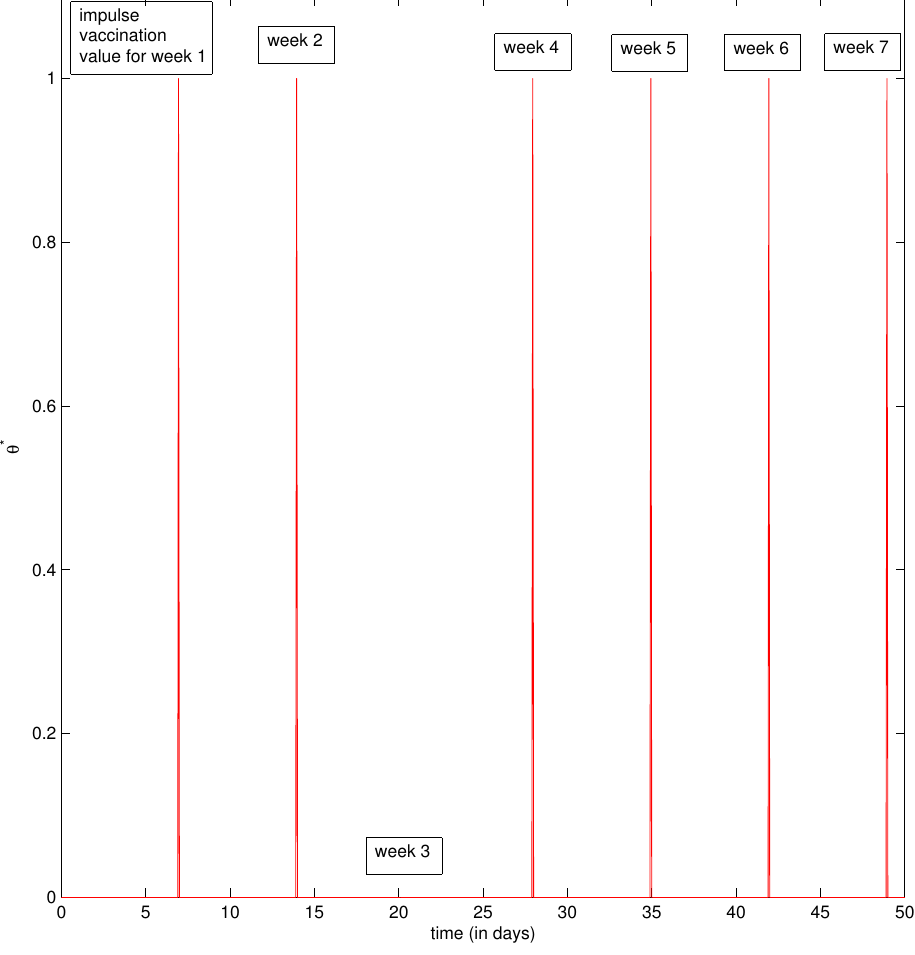
Figure 3. Value of the sought optimal